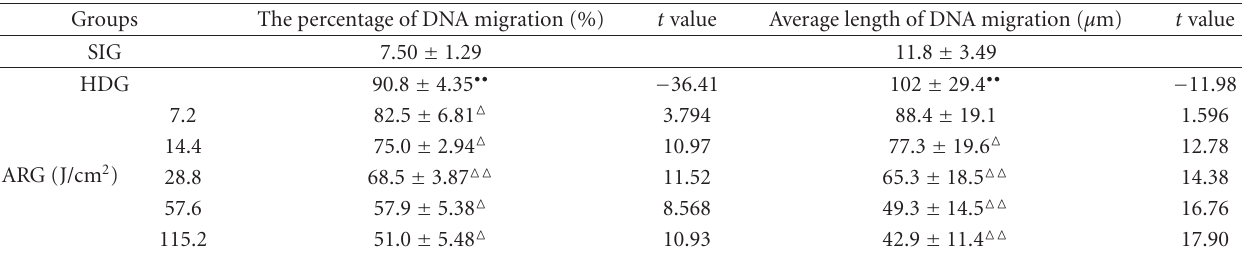
Table 4: E ff ects of low-dose UVA preirradiation on fibroblast DNA damage ( x ± S , n = 4).